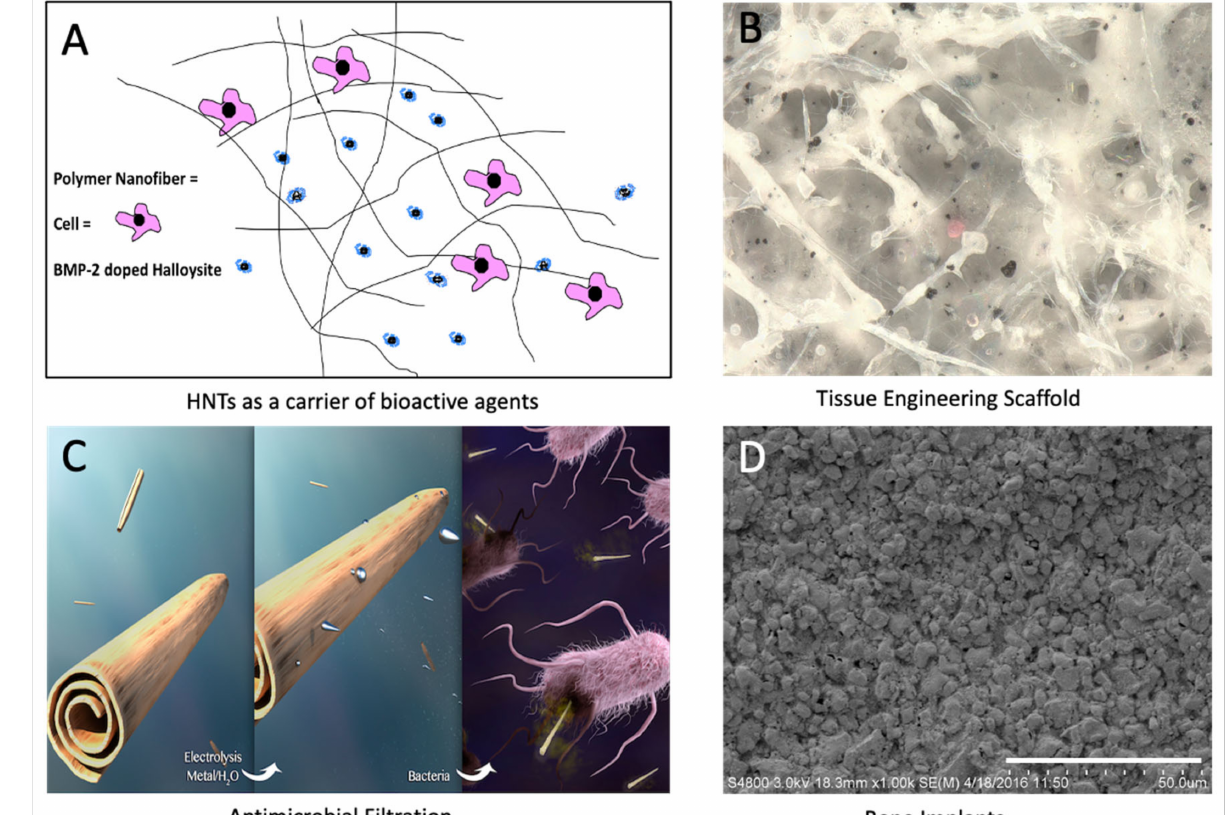
Figure 2. ( A ) Growth-factor-doped HNT nanofiber substrates. ( B ). Zinc-coated HNTs in PLA fibers for tissue regeneration. ( C ) Electrodeposition of silver nanoparticles onto the HNT surface for antimicrobial applications. ( D ) HNT and calcium phosphate cement for use as a bone